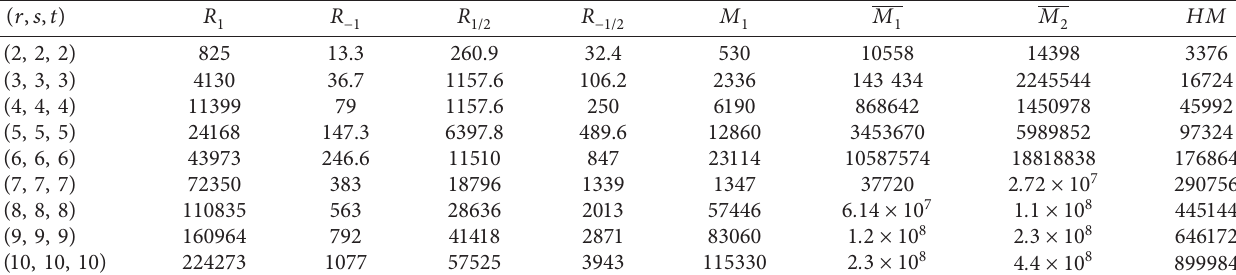
Table 4: Numerical comparison of indices of M [ r,s, t ] for some initial values of r,s, t ≥